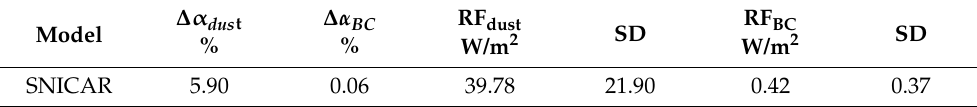
Table 3. Influence of particulate matter on the albedo on the QT No. 1 Glacier snow during July 2015.